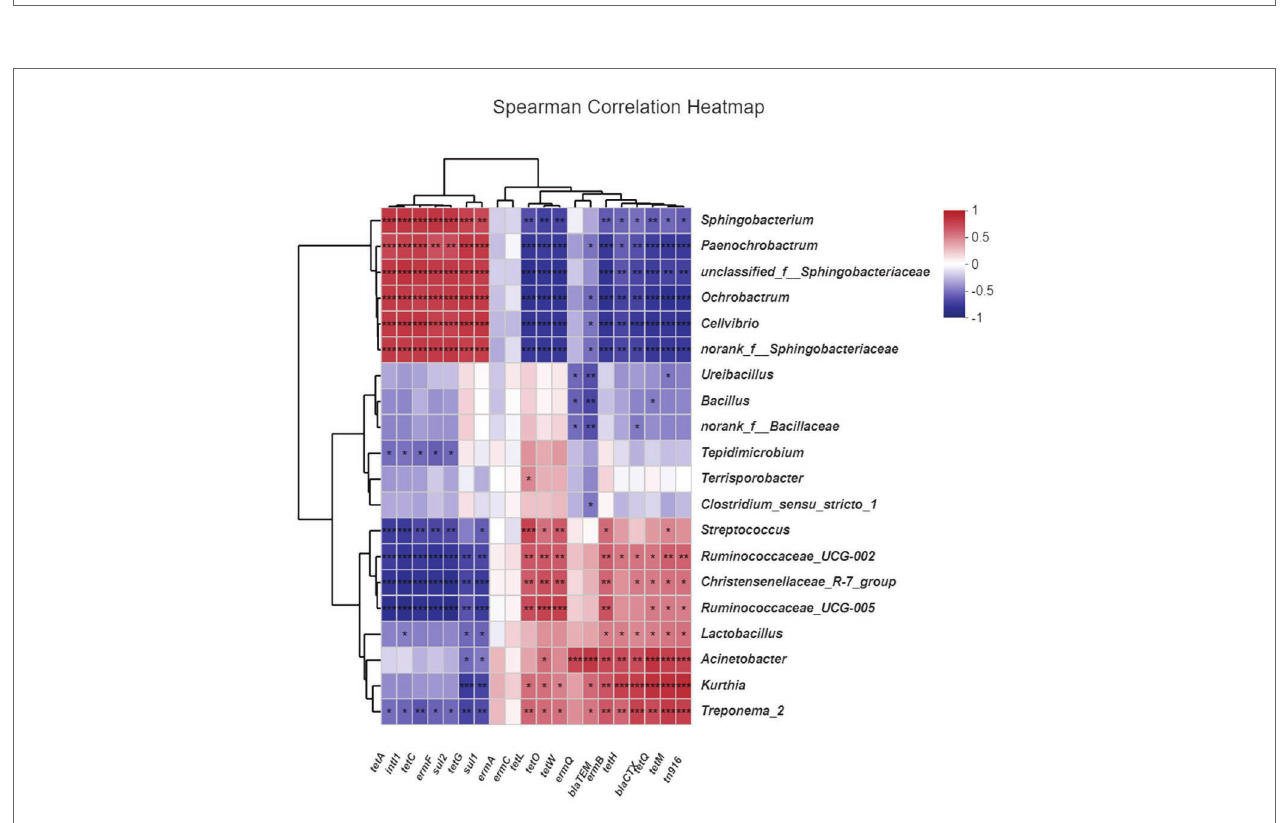
FIGURE 8 | Correlation between antibiotic resistance genes (ARGs), mobile genetic elements (MGEs), and microbial community. CK: the swine manure composting. AB: add 1% compound microbial agents in the swine manure composting. D1 represents the mesophilic phase, D2 represents the thermophilic phase, and D32 represents the maturation